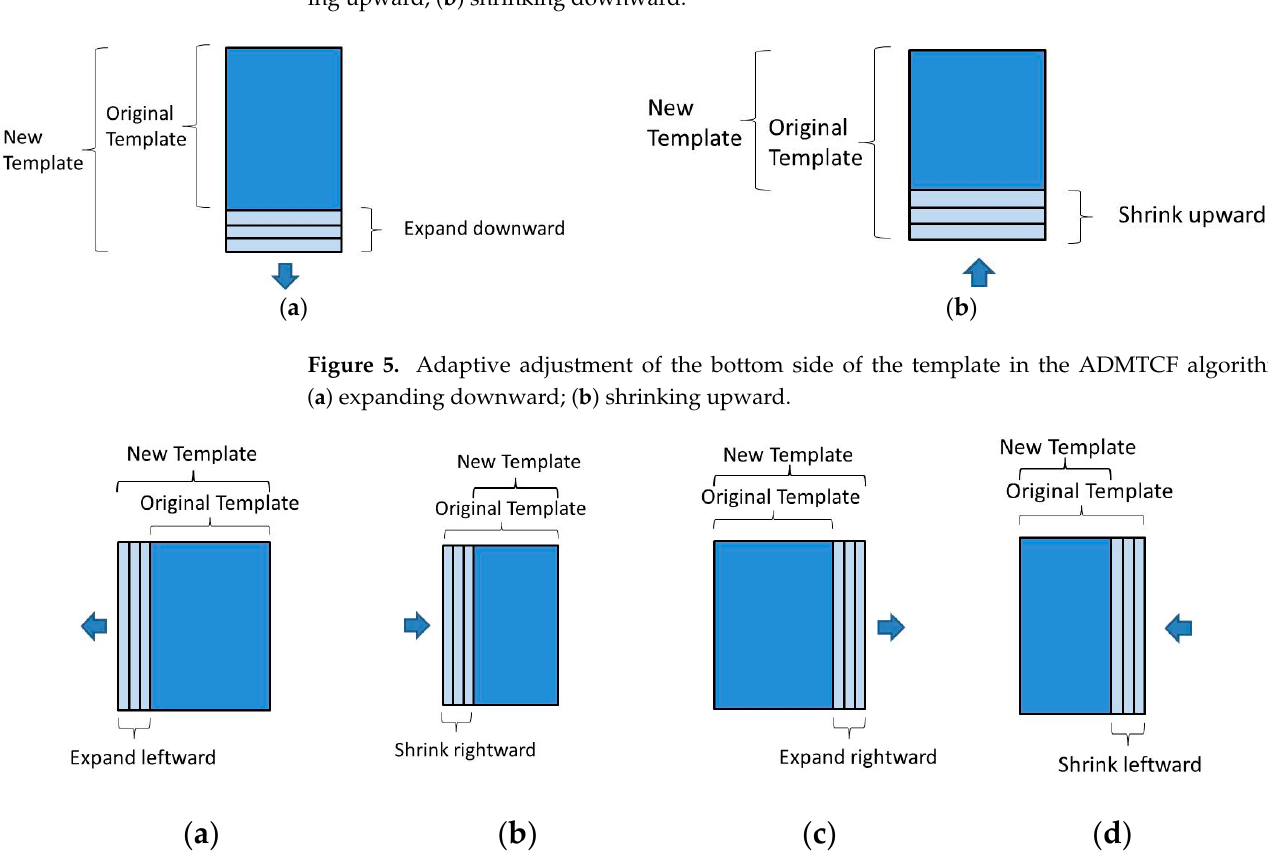
algorithm: ( a ) expanding leftward of the left side of the template; ( b ) shrinking rightward of the left